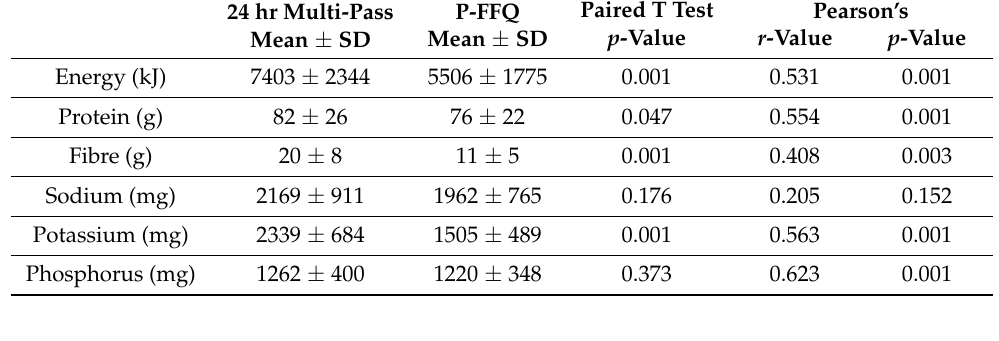
Table 2. Correlations between dietary intake according to 24 hr multi pass recall and P-FFQ ( n = 50).